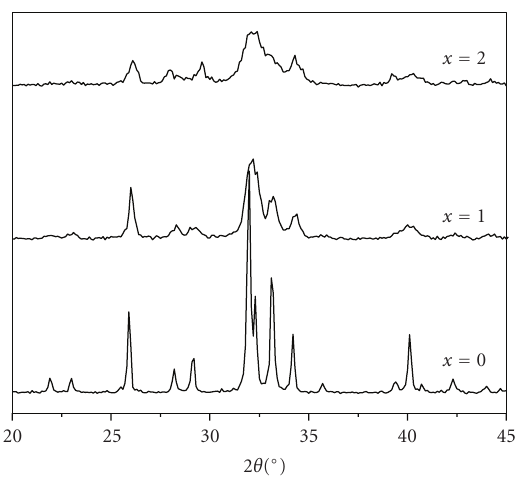
Figure 1: X-ray powder di ff raction patterns of M x FA samples.